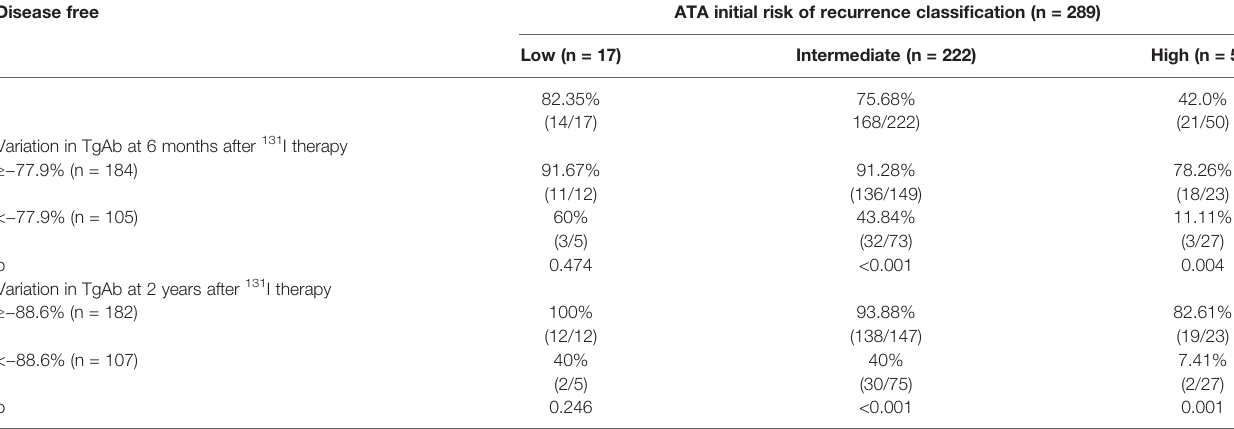
TABLE 7 | Restrati fi cation of the ATA risk categories according to the variation in TgAb relative to the preoperative level. Disease